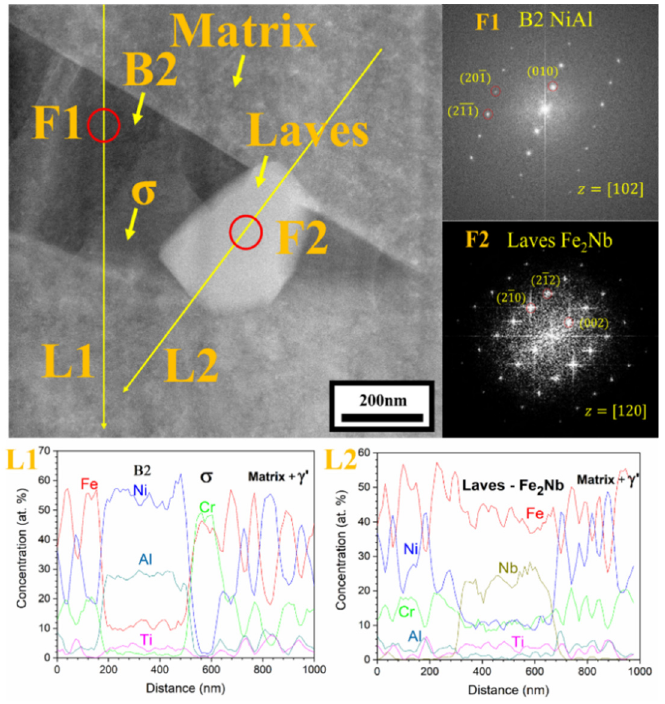
Figure 10. STEM-EDS line scan analysis with FFT pattern for the needle-like B2-NiAl phases and adjacent Laves phase in alloy 43+ SA after the creep test in air at 750 °C and 150 MPa.